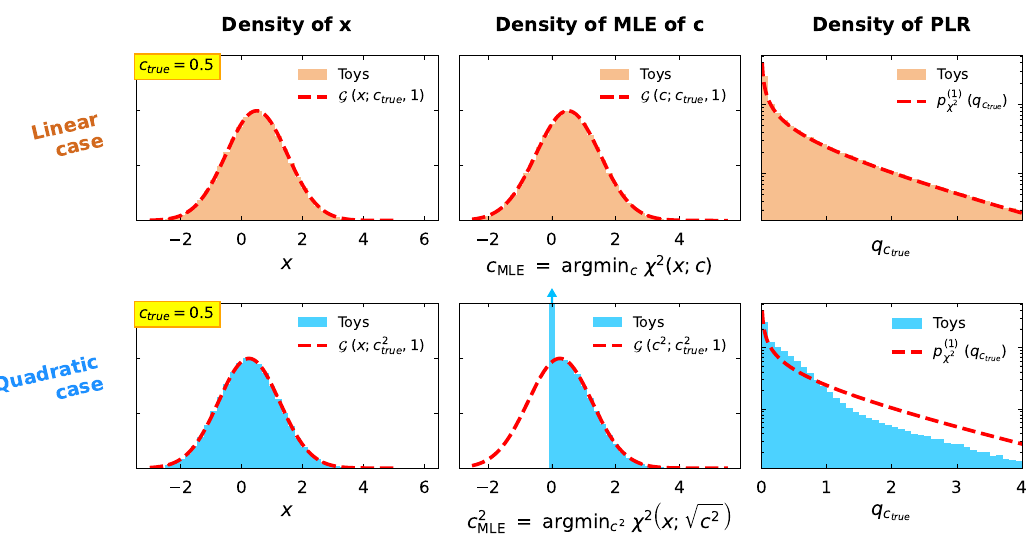
Figure 1: Visualisation of how Wilks’ theorem is violated when a parameterisation cannot fit data fluctuations which fall beyond some boundary. This behaviour is observed in quadratic EFT fits (bottom row), which cannot access data below the SM